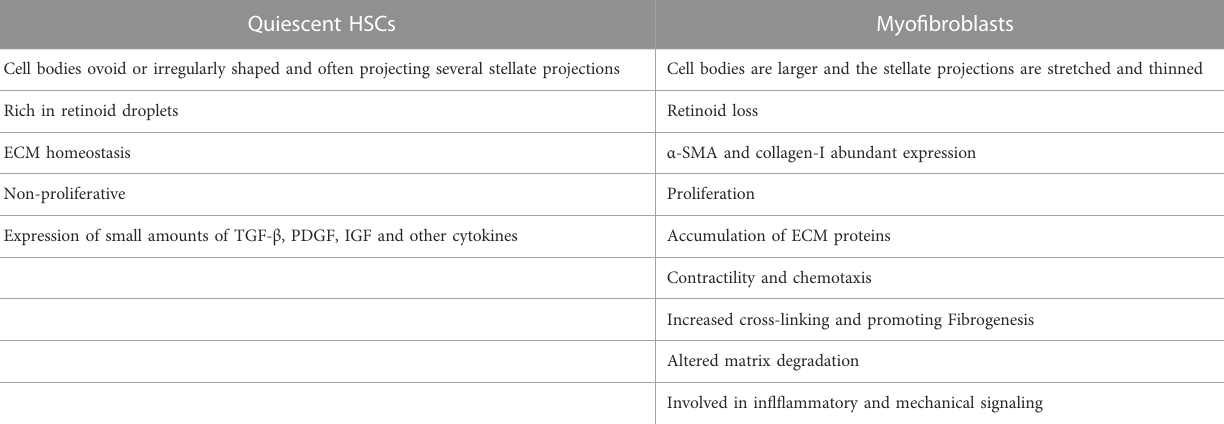
TABLE 1 The differences between myo fi broblasts versus quiescent HSCs that cause ECM imbalance and hepatic fi